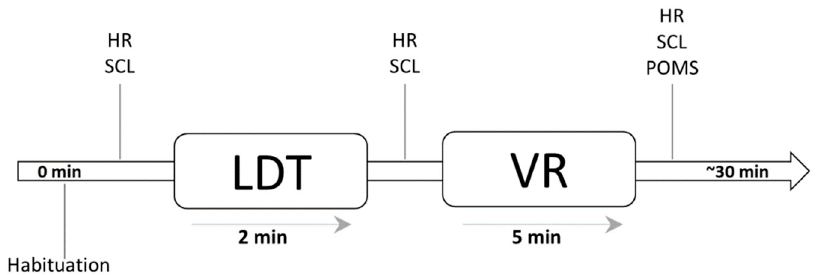
Figure 3. Timeline of the experimental process (LDT = letter-detection test; VR = virtual reality; HR = heartrate; SCL = skin conductance level; POMS = Profile of Mood States).